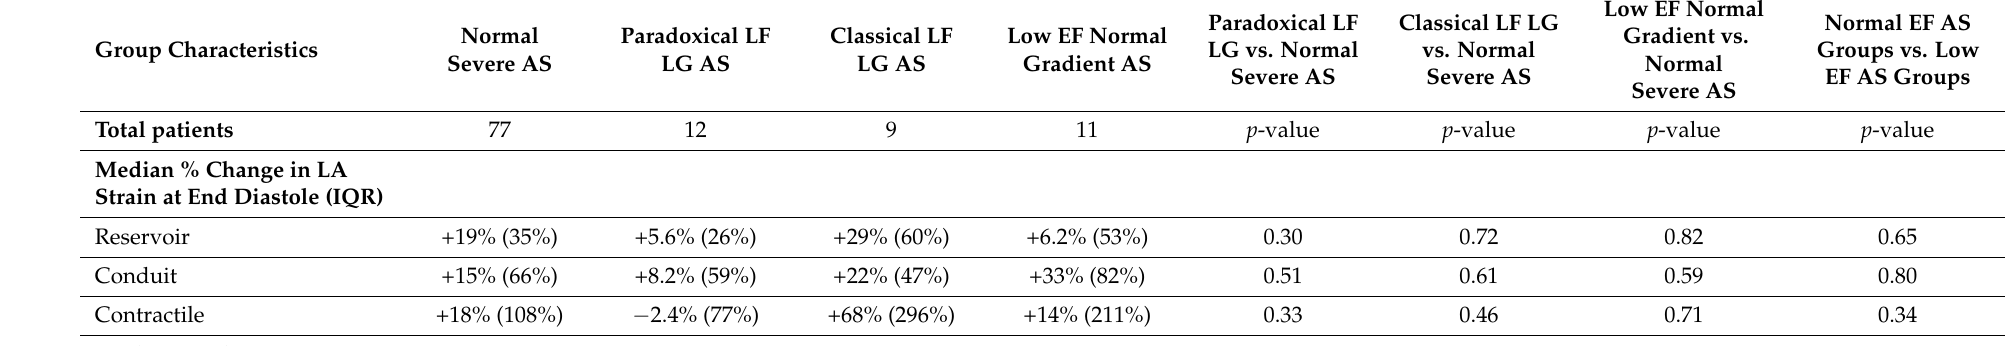
Table 4. Symptoms and echocardiographic parameters 30 days post TAVR, according to AS